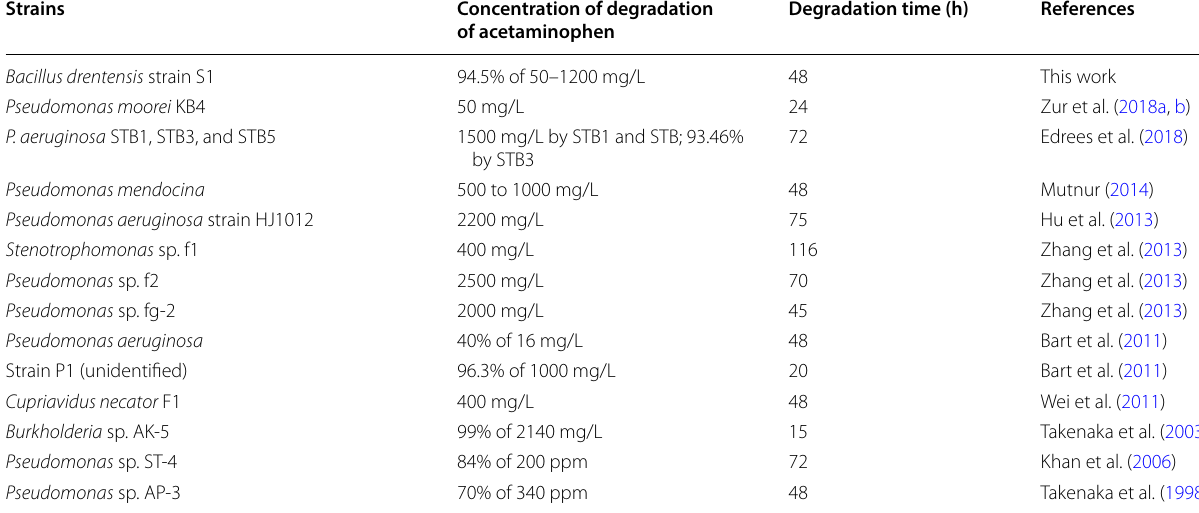
Table 3 The reported bacterial strains with potential acetaminophen degradation